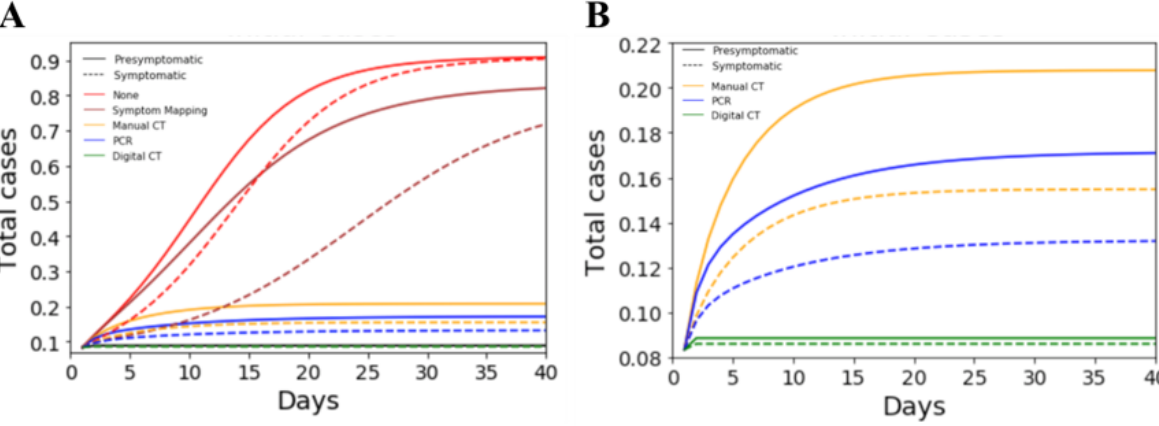
Figure 4. Assessing the impact of presymptomatic cases on facility spread. Simulations were performed to compare transmission and interventional control for two initial seeding conditions: presymptomatic (filled colored lines: 10 presymptomatic and 0 symptomatic cases) and symptomatic (dotted colored lines: 0 presymptomatic and 10 symptomatic cases). Simulations were performed to measure the number of total cases as a function of time for each intervention group: digital contact tracing, PCR testing, manual contact tracing, symptom-based monitoring, and no intervention. A: total cases over time for each intervention group and initial seeding condition. B. Total cases over time for manual contact tracing, PCR testing, and digital contact tracing. CT: contact tracing; PCR: polymerase chain reaction.